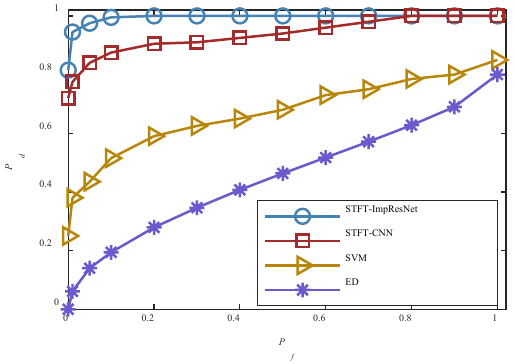
Figure 9. ROC curves of different algorithms.